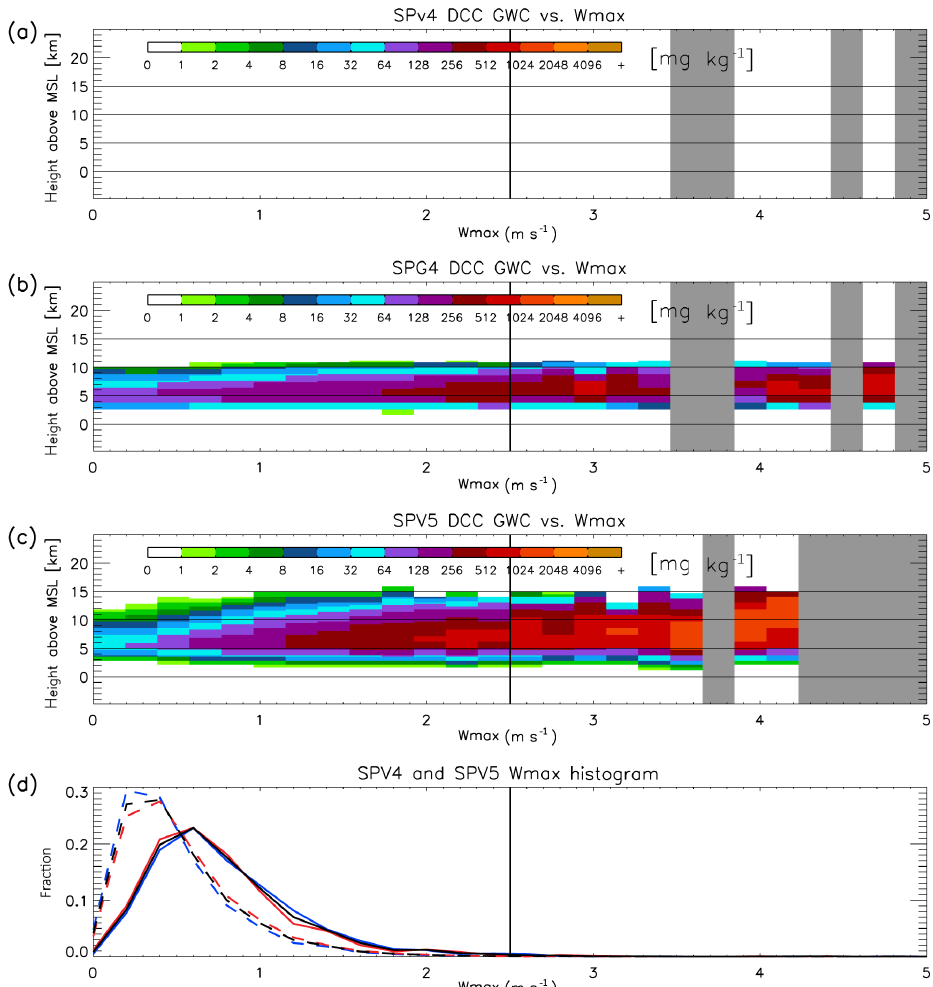
Figure 10. Same as Fig. 8, but for graupel water content (GWC). Note the absence of GWC for